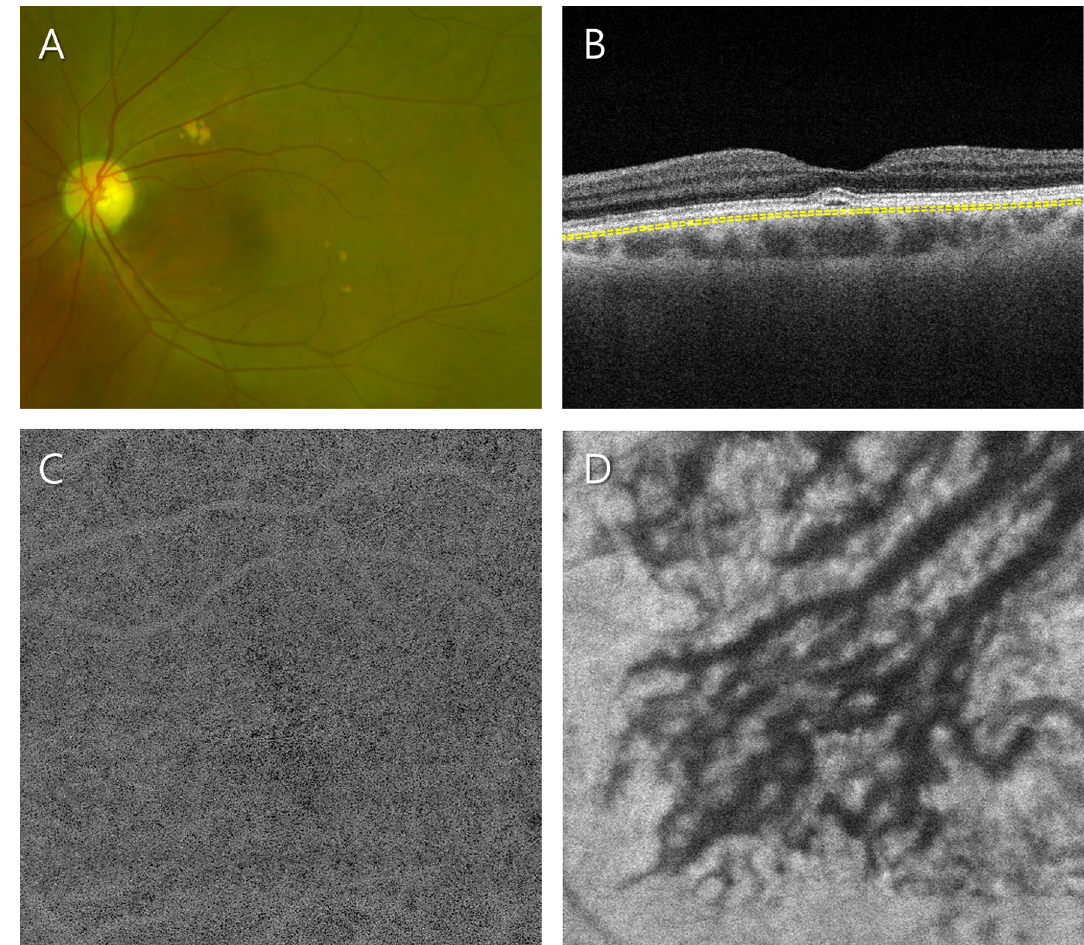
showing an increased choroidal thickness with dilated Haller vessels. The subfoveal choroidal thickness was 275 µm. Slab to acquire the choriocapillaris (CC) layer is depicted as a yellow dashed line. ( C ) OCT angiography (OCTA) image of the CC. The characteristics of the flow voids were similar to those in the control group in that the relatively small flow voids were evenly distributed throughout the scanned area, while sparse focal defects were observed. The average size, number and total area of flow voids were 217.9 µm 2 , 26,831, and 6.1 mm 2 , respectively. ( D ) Structural en face OCT image of the Haller layer. Dilated Haller vessels are prominent. The mean and standard deviation of the Haller vessel diameter were 141.8 and 79.3 µm,